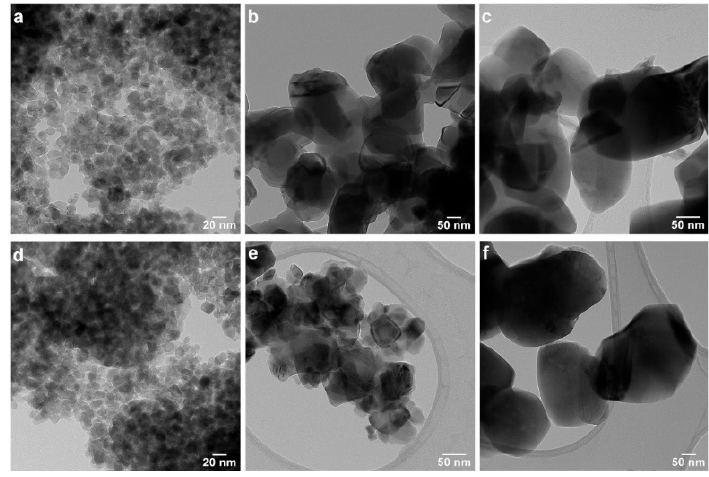
Figure 3. TEM images at higher magnifications, revealing the samples’ morphology: ( a ) T400W, ( b ) T550W, ( c ) T800W, ( d ) T400B, ( e ) T550B, and ( f ) T800B.